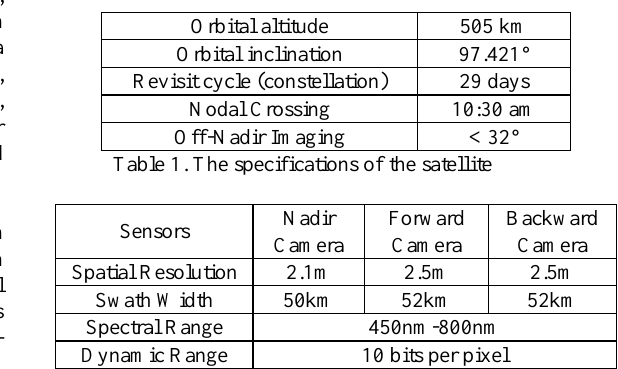
Table 2. The specifications of the